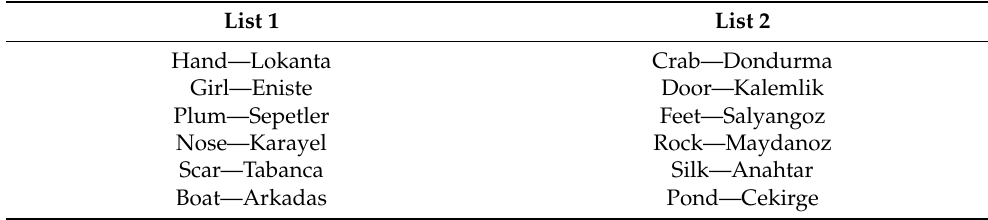
Table A2. English word –Turkish word pairs used in the wordform learning task. The bolded syllables show the main stress in the